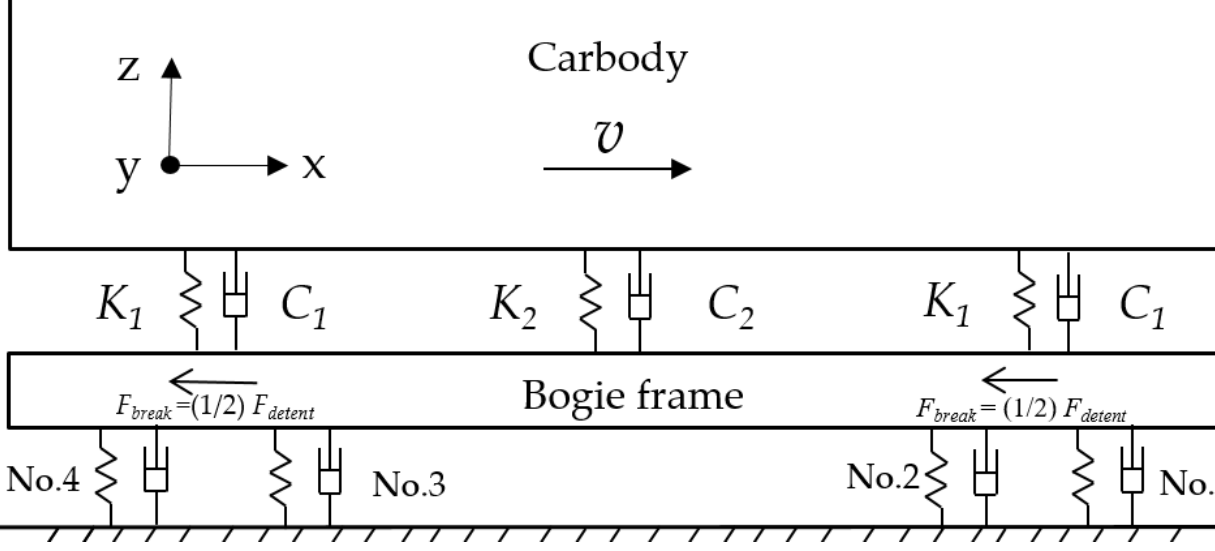
Figure 7. Schematic of dynamic model of the HTS maglev test vehicle. Table 3. The main parameters related to the test